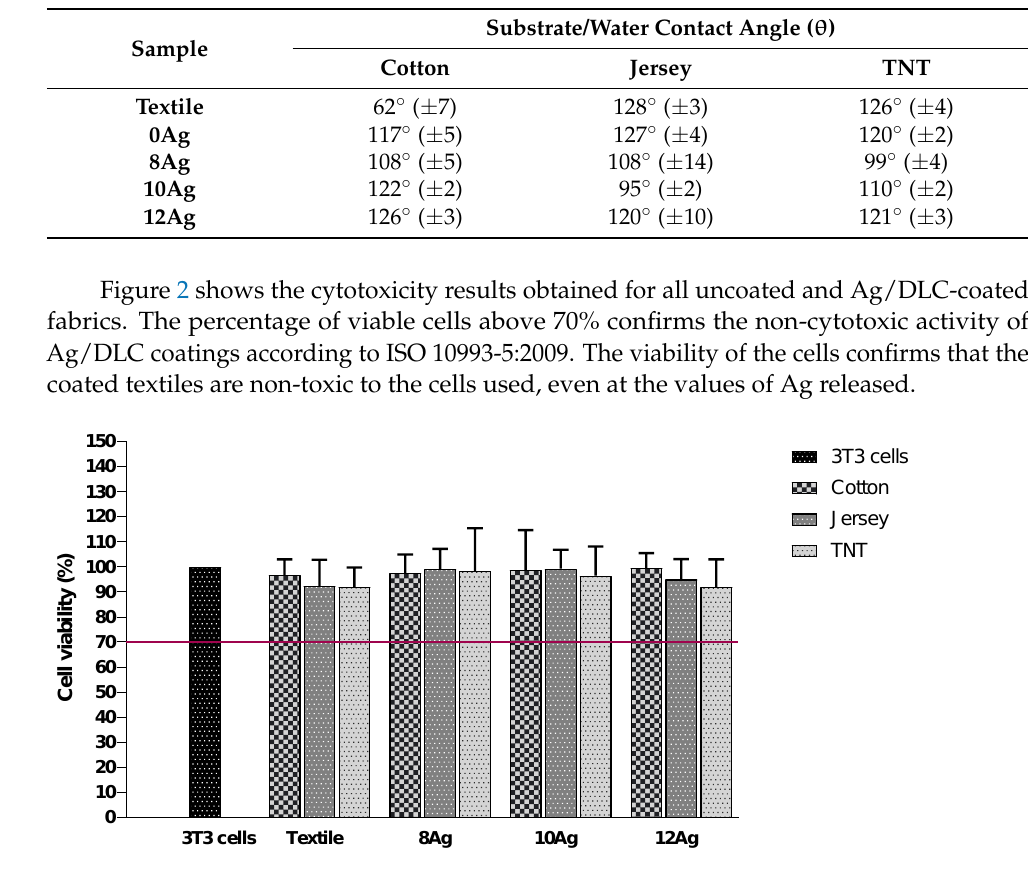
Table 2. Contact Angles ( θ ) results for the coated and uncoated substrates using water as the reference liquid.